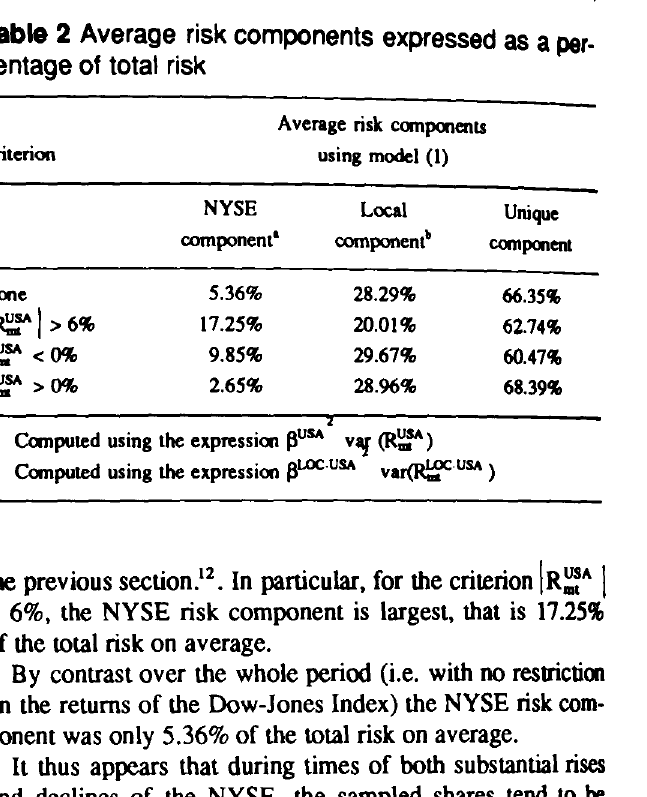
Table 2 Average risk components expressed as a per centage of total